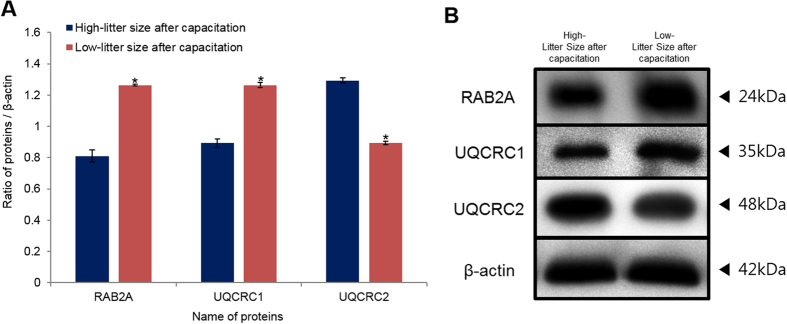
Expression of Ras-related protein Rab-2A (RAB2A), cytochrome b-c1 complex subunit 1 (UQCRC1), and cytochrome b-c1 complex subunit 2 (UQCRC2) in high- and low-litter size spermatozoa after capacitation.(A) Ratios of RAB2A, UQCRC1, and UQCRC2 (optical density [OD × mm]/β-actin [OD × mm]) in high- and low-litter size spermatozoa after capacitation (Navy bar: high-litter size after capacitation, Red bar: low-litter size after capacitation). Data represent the mean ± SEM, n = 3. Protein expression ratios denoted with an asterisk were significantly different (*P < 0.05). (B) RAB2A, UQCRC1, and UQCRC2 were probed with anti-RAB2A, anti-UQCRC1, and anti-UQCRC2 antibodies.